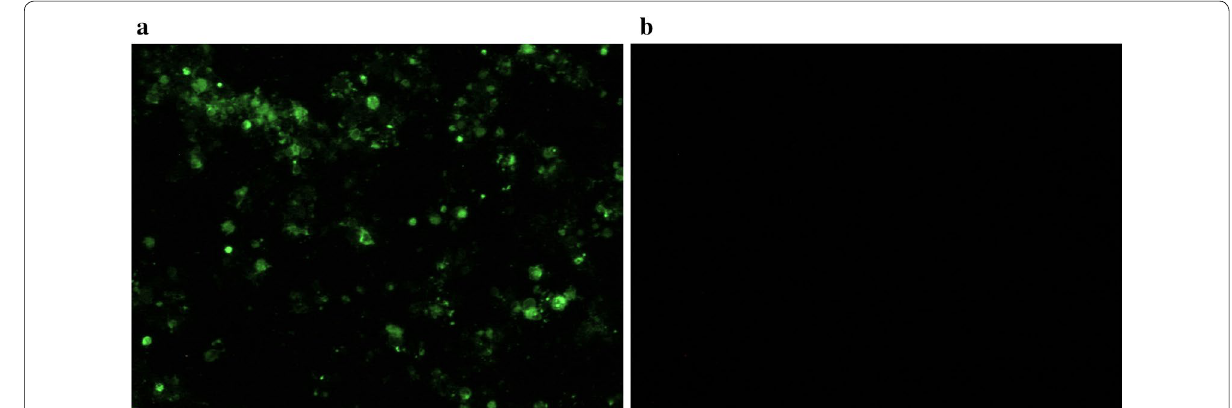
Fig. 2 IFA of the mAb 9F12. H3-subtype AIV-infected or mock-infected MDCK cells were fixed with ice-cold methanol and then incubated with the mAb 9F12. After incubation with a FITC-conjugated goat anti-mouse IgG secondary antibody, the cells were visualized by fluorescence microscopy.